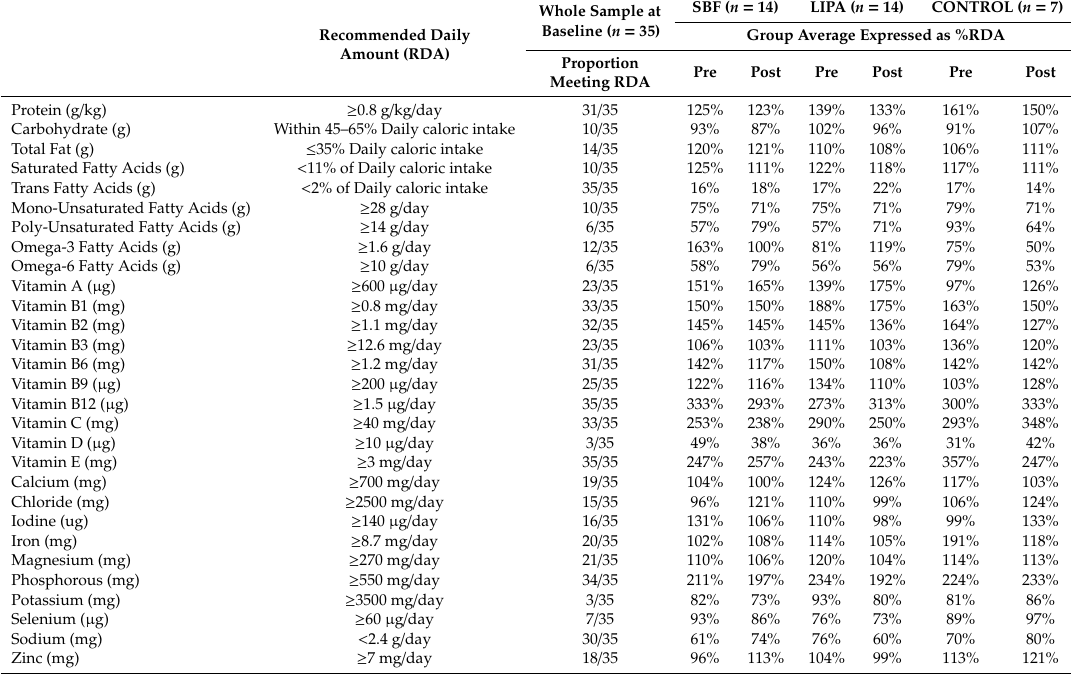
Table 3. Habitual dietary outcomes expressed relative to recommended daily amounts